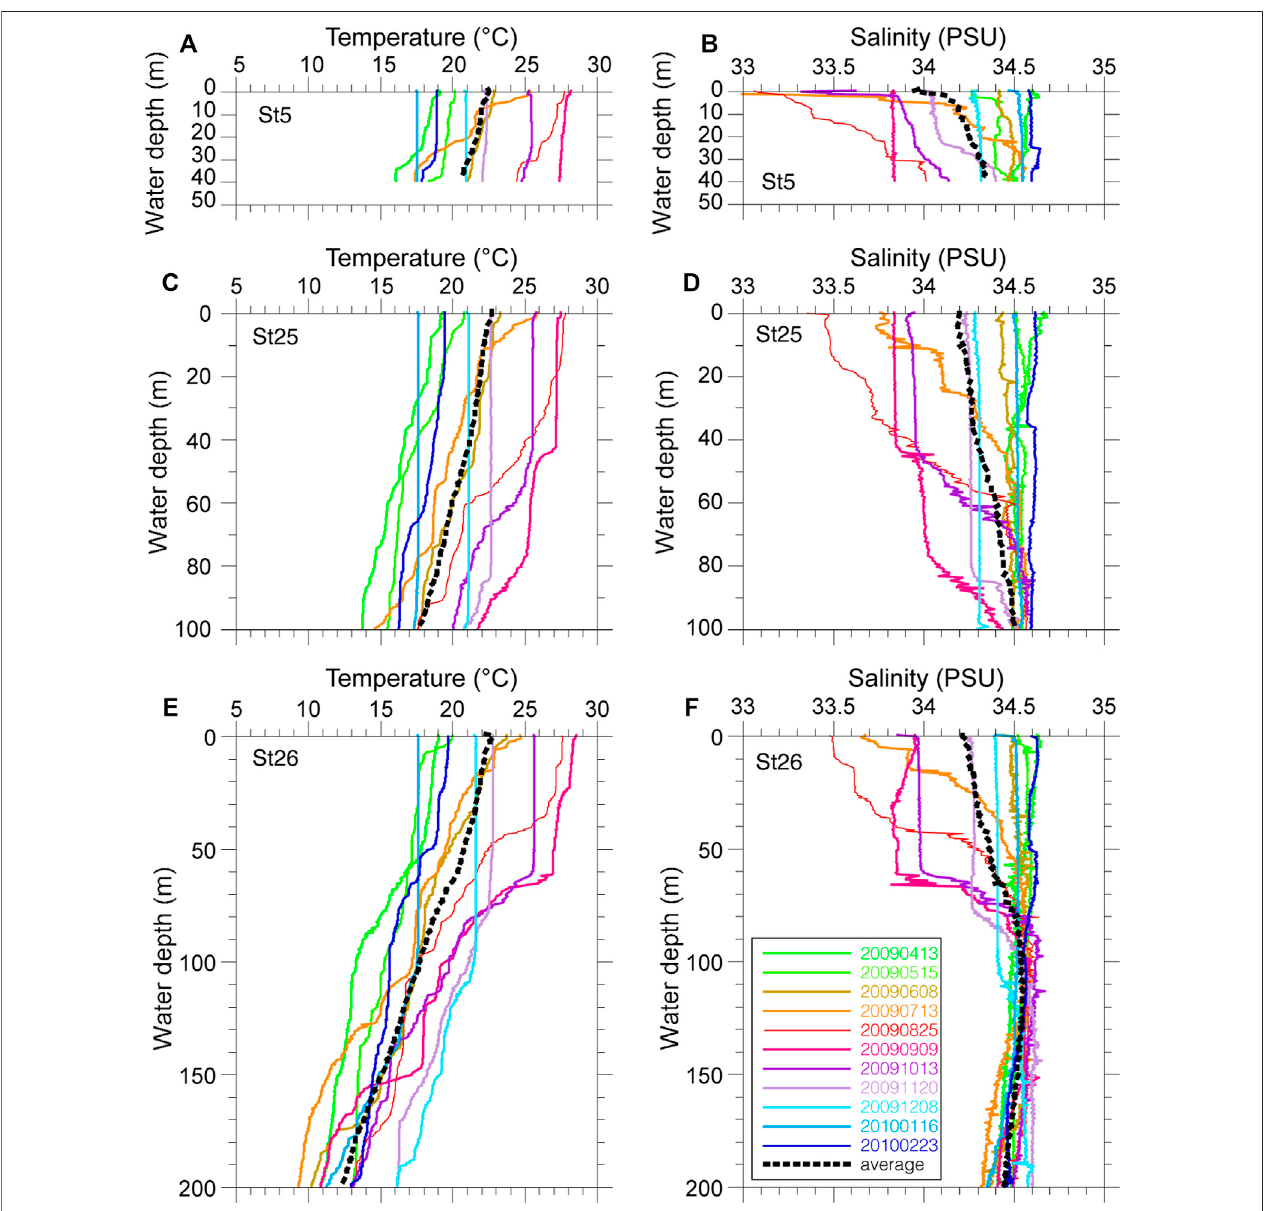
FIGURE 3 | Measured temperature and salinity pro fi les at three sites in Tosa Bay. (A) temperature and (B) salinity at site 5, (C) temperature and (D) salinity at site 25, (E) temperature and (F) salinity at site 26. Thin colored lines are monthly values, heavy dashed lines are annual mean values (April 2009 to February 2010).